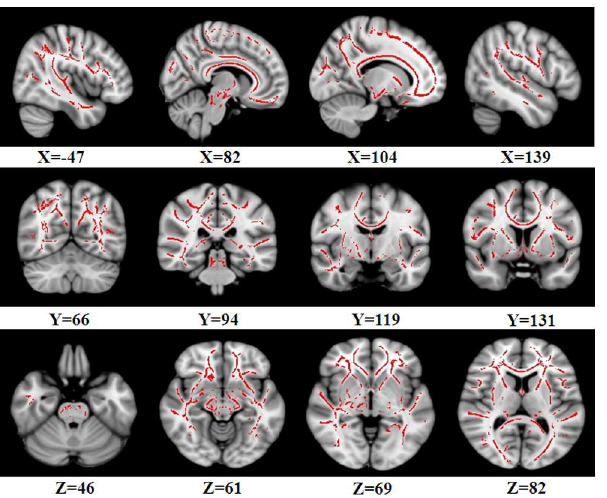
Fig 1. Regions showing significant FA differences among NC, aMCI-s and aMCI-m based on ANCOVA. The thresholdwas set at a TFCE-corrected P-value of less than 0.01 and a minimum cluster size of 50 contiguous voxels. Left is the left.